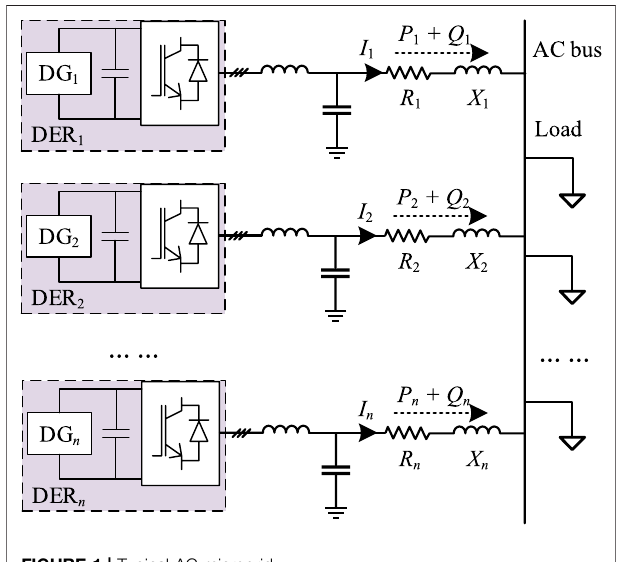
FIGURE 1 | Typical AC